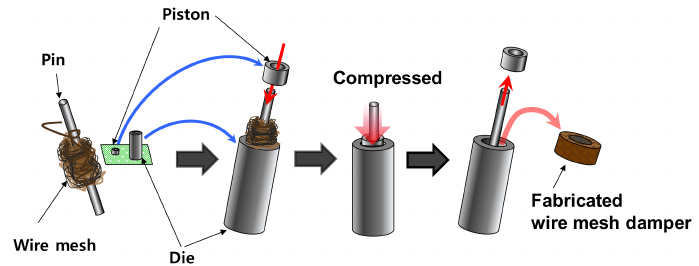
Figure A1. Fabrication procedure of a wire mesh damper.